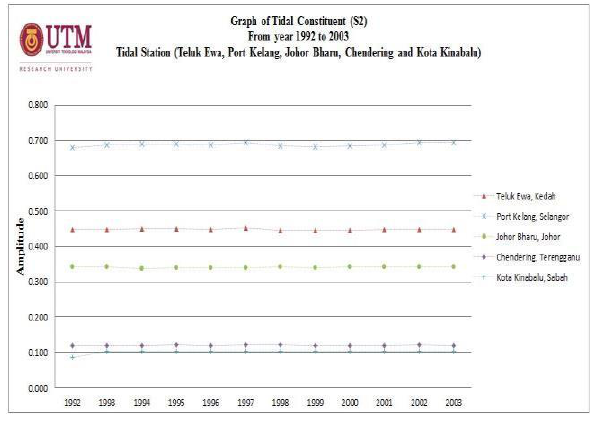
Figure 5. Graph of Tidal Constituent for S2 Figure 5 shows the graph plotted based on the value amplitude of